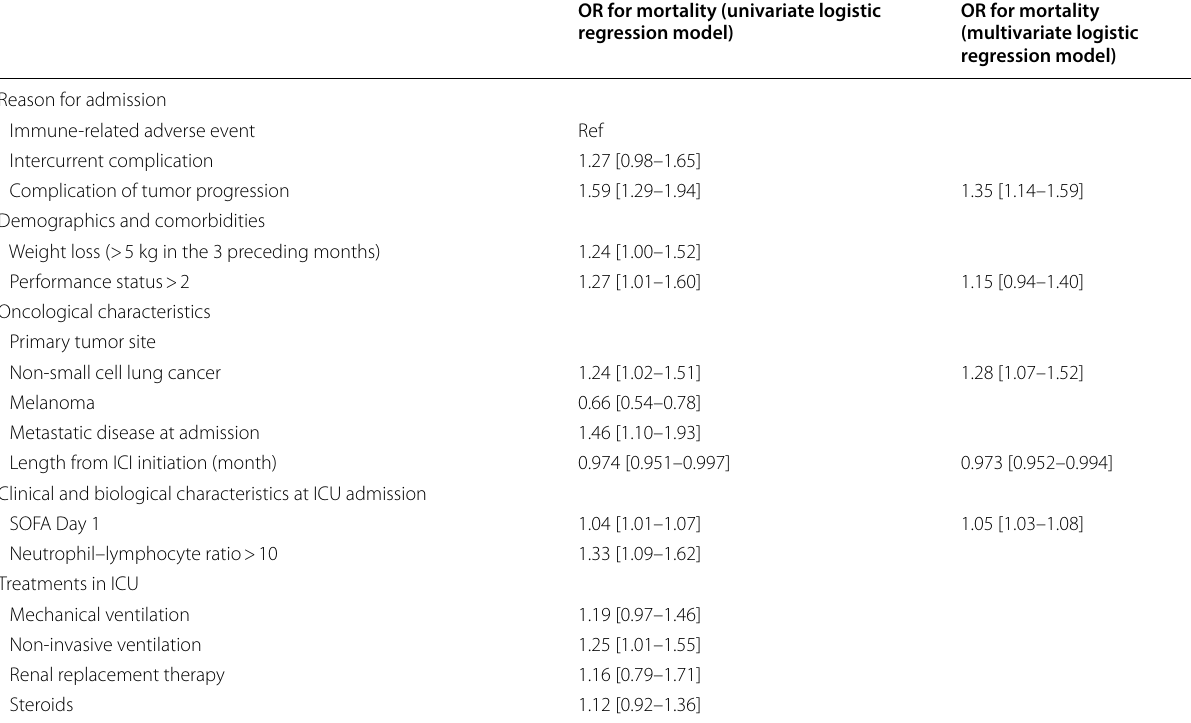
Hazard ratios and their 95% confidence interval are shown for factors associated with 12-month mortality in univariate and multivariate analyses